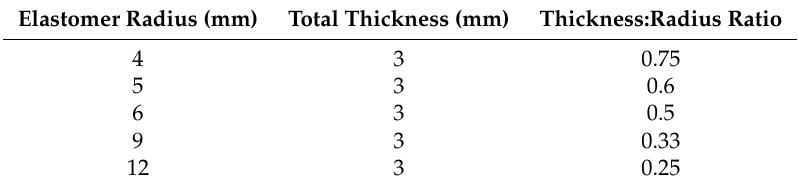
Figure 5. ( a ) Schematic model used in the elastomer mechanics simulation, indicating the main components, and boundary conditions applied. The symmetry boundary conditions were applied across the full z-r plane, red boundaries signify a tied boundary condition. Displacement was applied and reaction force was measured from reference points along the central axis of the model; and ( b ) Typical output from the finite element simulation, contours represent displacement ( U ) magnitude. Table 2. Parameters of elastomer geometry used in the mechanical